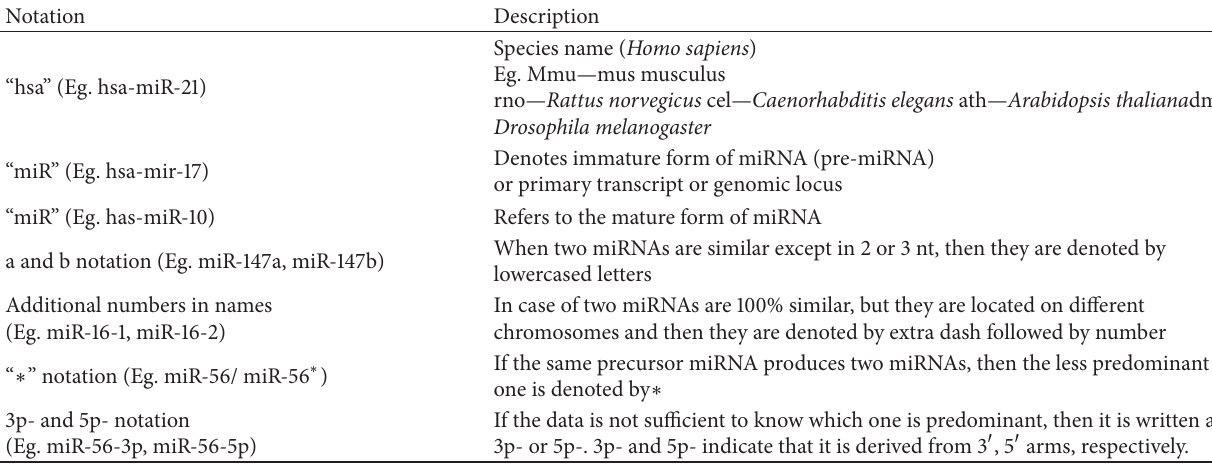
Figure 3: miRNA mediated regulation of translation at postinitiation stage. (a) Ribosome drop-off is the proposed mechanism where translation is initiated and miRNA directed ribosomes to inhibit the translation prematurely. (b) Other possible mechanisms of miRNA mediated translation repression are nascent polypeptides which are degraded by proteosomes. Table 1: miRNA